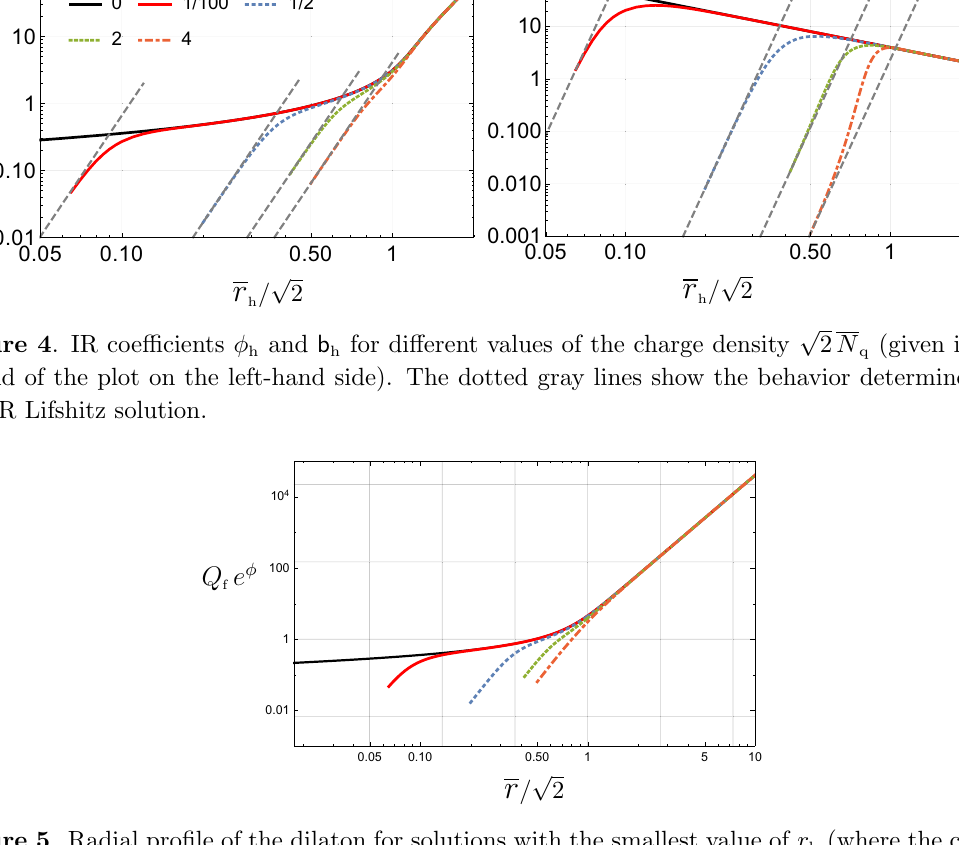
(where the curves h